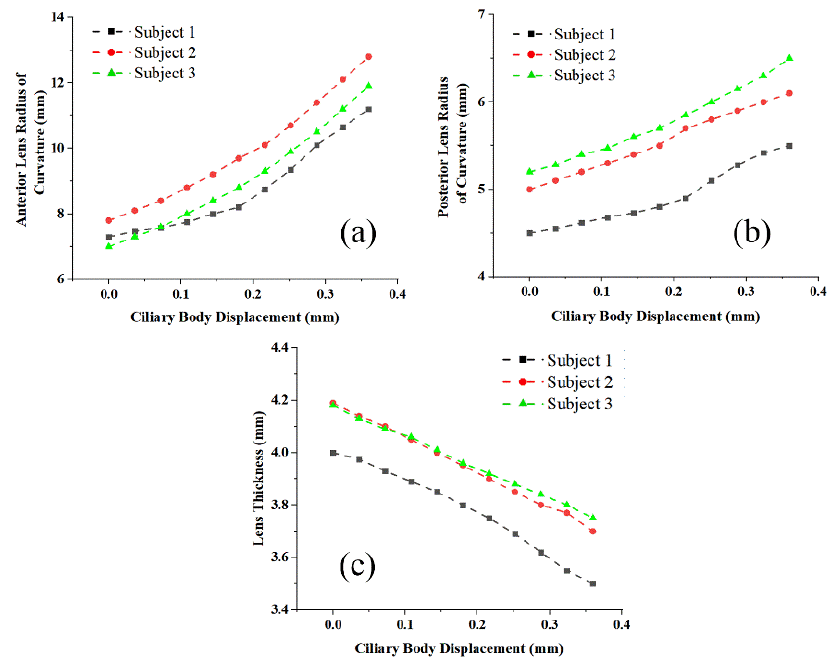
Figure 5. Variations of geometric parameters of lens finite element model with ciliary body pulling in 3 subjects: ( a ) curvature radius of anterior surface; ( b ) curvature radius of posterior surface; ( c ) lens thickness.